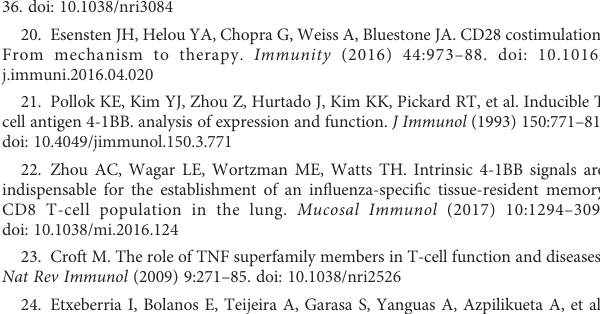
SUPPLEMENTARY FIGURE 2 Subgroup analysis for PFS of PCSK9 hi and PCSK9 lo group. *PD-L1 negative, TPS<1%; PD-L1 low, TPS<50%; PD-L1 high, TPS ≥ 50%.